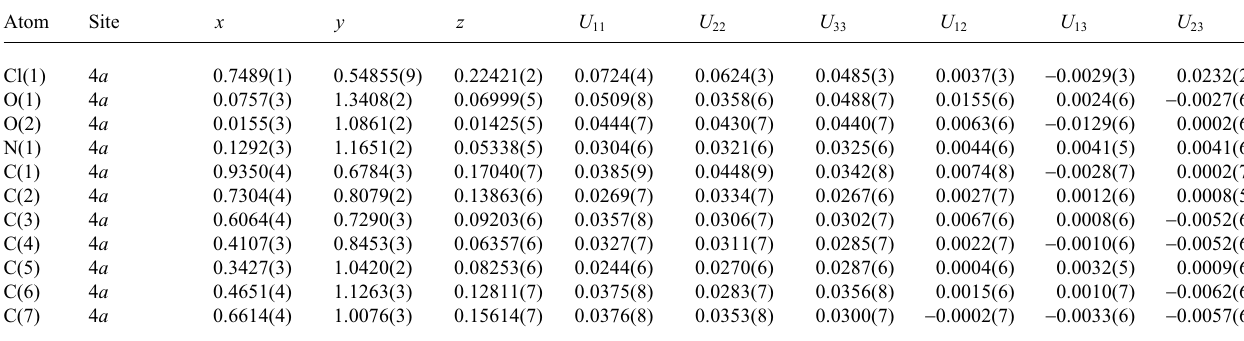
Table 3. Atomic coordinates and displacement parameters (in Å 2